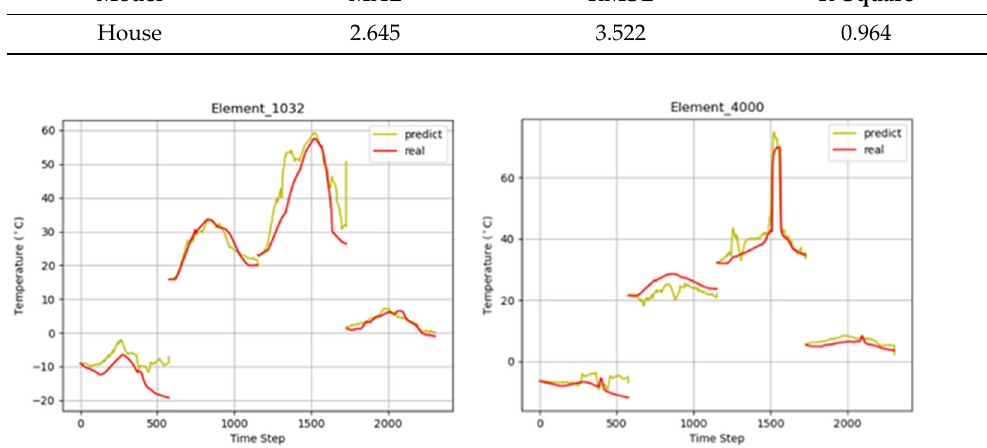
Figure 13 Prediction of the temperature field of complex objects. Figure 13. Prediction of the temperature field of complex objects.